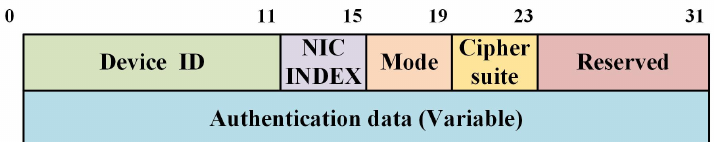
Figure 8. Packet header.